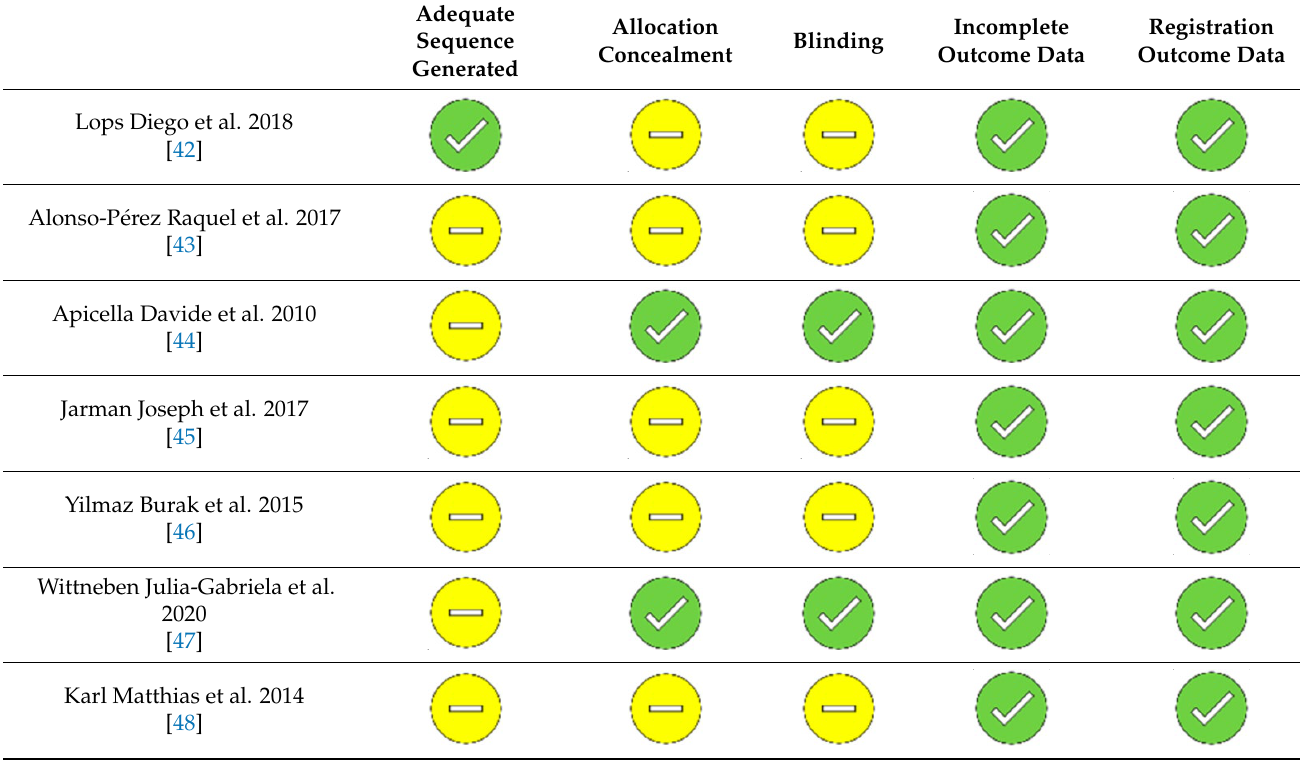
Table 1. Risk of bias of the studies is represented by the green symbol for a low risk of bias and a yellow symbol for a moderate risk of bias.